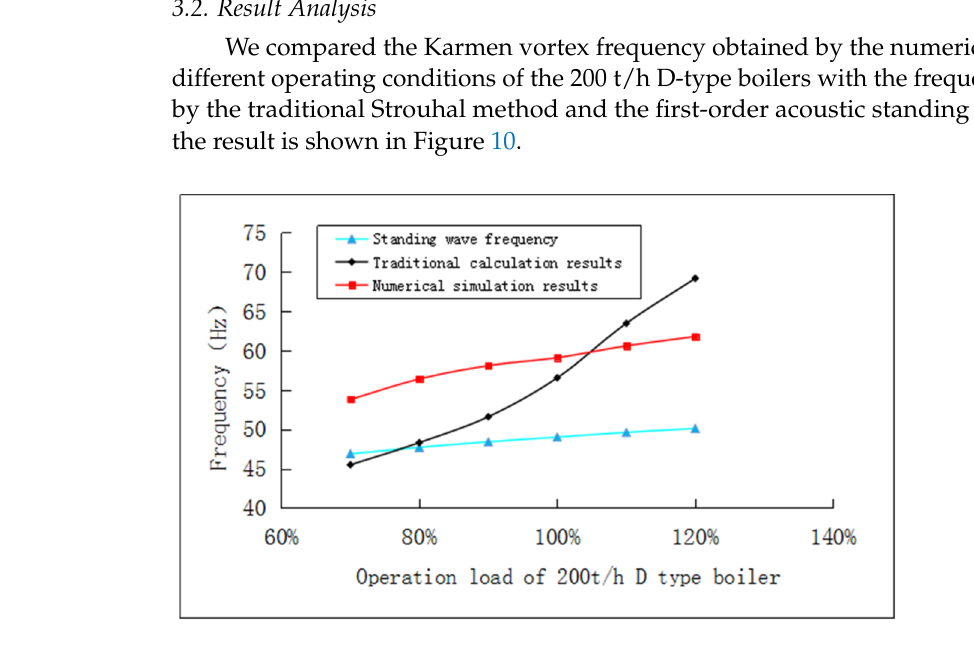
Figure 10. Comparison between the first-order acoustic standing wave frequency in different oper- ating conditions and the Karmen vortex shedding frequency obtained with different calculation